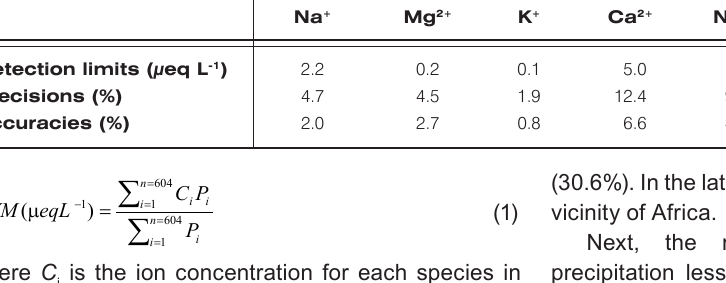
Table 1. Detection limits, precisions and